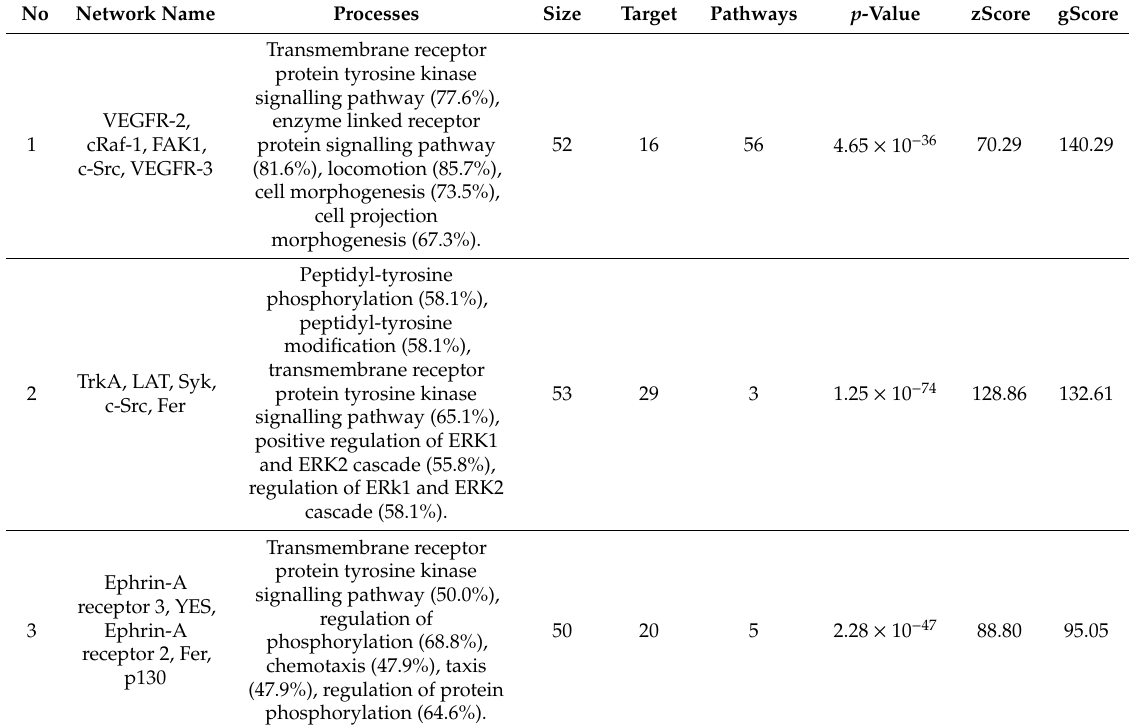
Table 2. Top three networks found in the 12 luminal-A Saudi